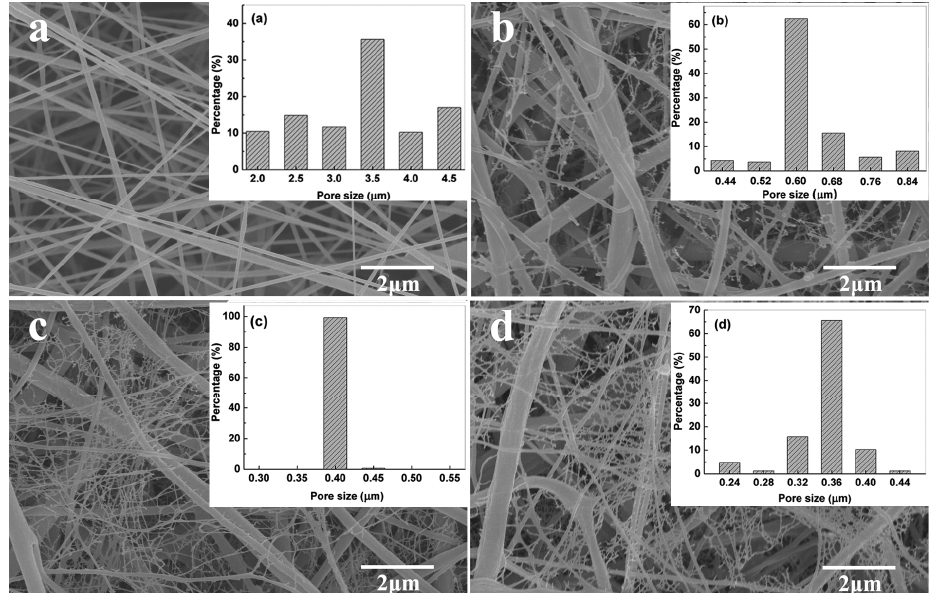
Figure 1. Field emission scanning electron microscopy (FE-SEM) images of polyvinylidene fluoride (PVDF) nanofiber membranes with different tetrabutylammonium chloride (TBAC) concentration: